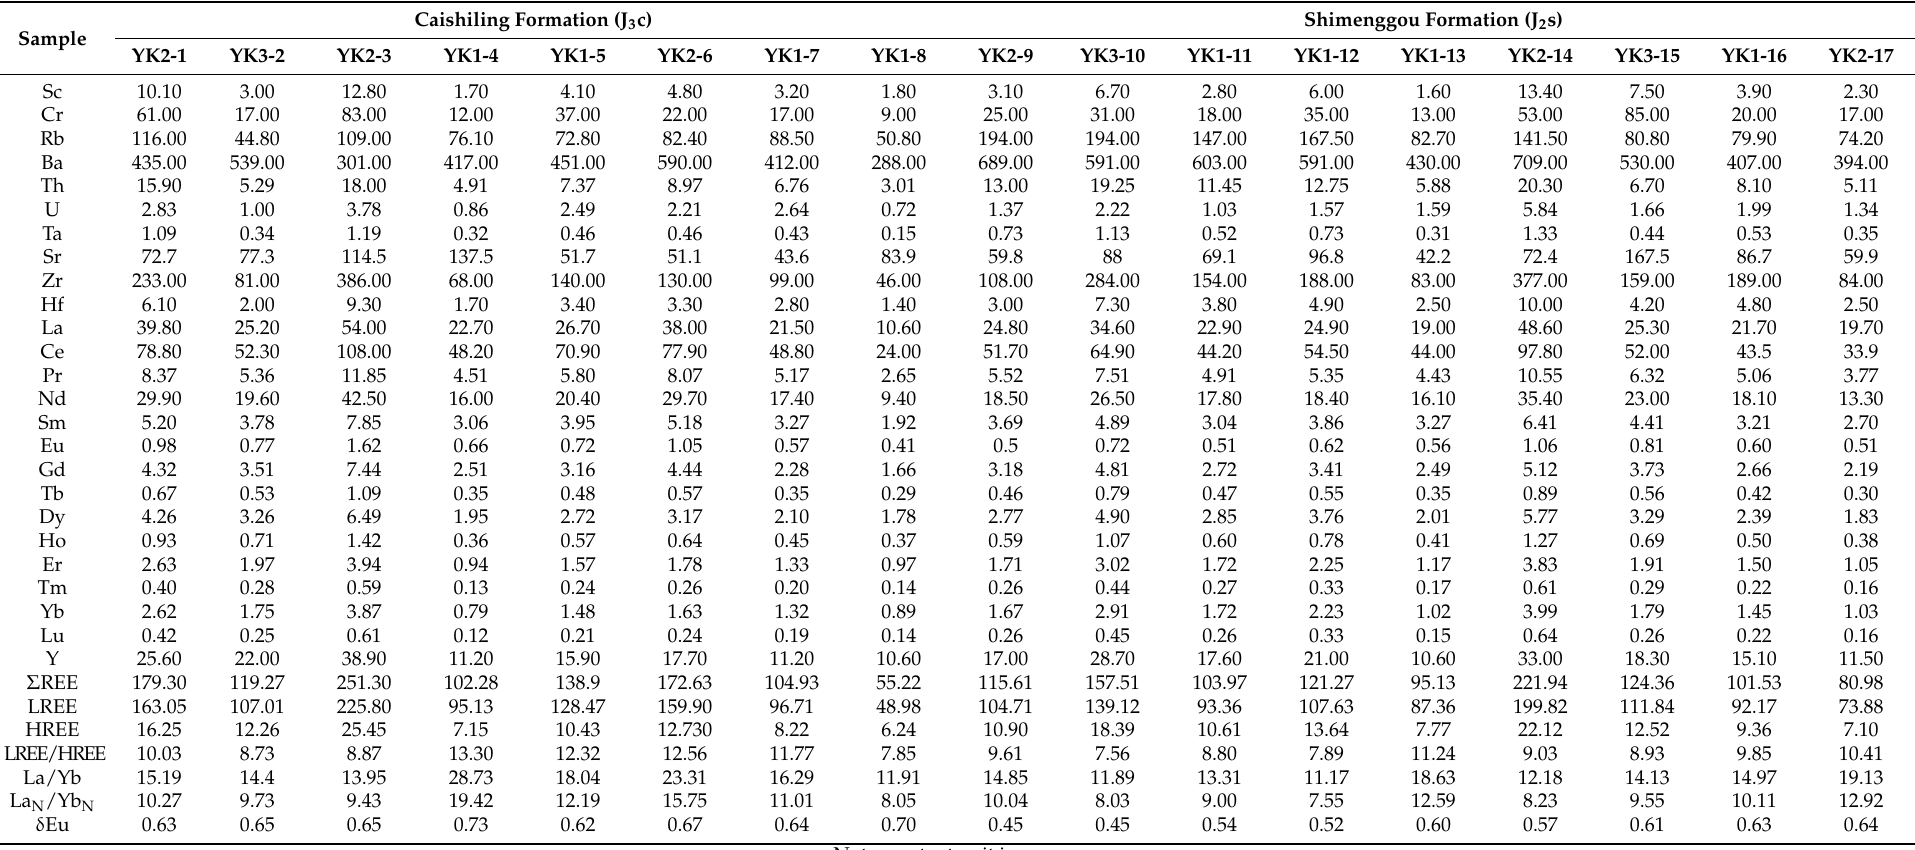
Table 2. Trace element analysis results of Jurassic sandstones in the Yuqia Area (w B